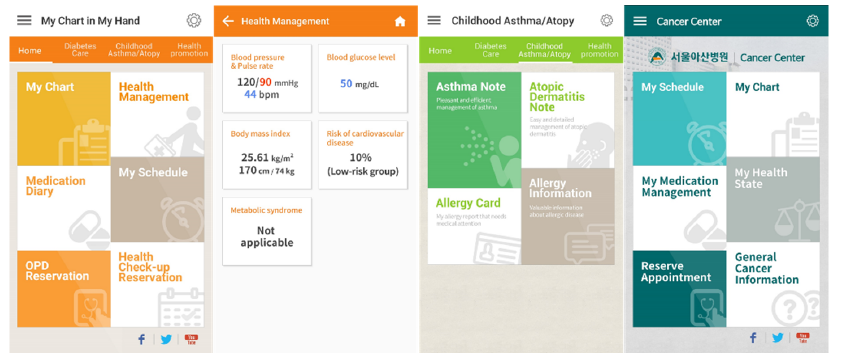
Figure 1. Screenshots of “Home” menu, “Health Management” menu, “Childhood Asthma/Atopy” menu, and “Cancer Center” from My Chart in My Hand version 2.0.